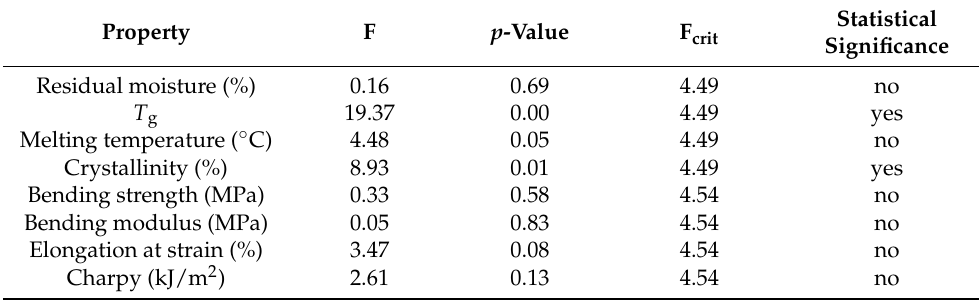
Table 3. Statistical analysis of the obtained results for flakes and commercial regranulates.